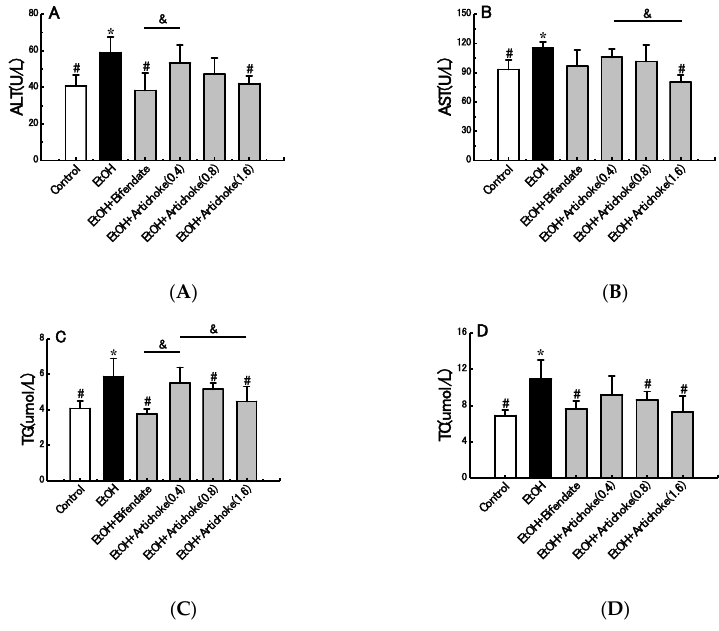
Figure 1. Effects of artichoke on levels of ALT ( A ), AST ( B ), TG ( C ), and TC ( D ). Values represent means ± standard deviation (SD) ( n = 10); * p < 0.05 vs. the control group; # p < 0.05 vs. the EtOH group; & p < 0.05. ALT: alanine aminotransferase; AST: aspartate aminotransferase; TG: triglycerides; TC: total